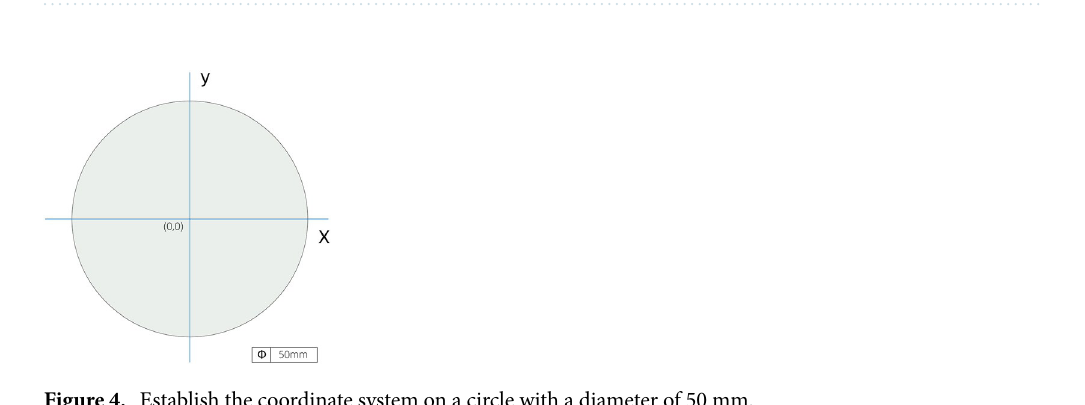
Figure 3. Find the cut point on the coordinate system using the Riemann integral algorithm.